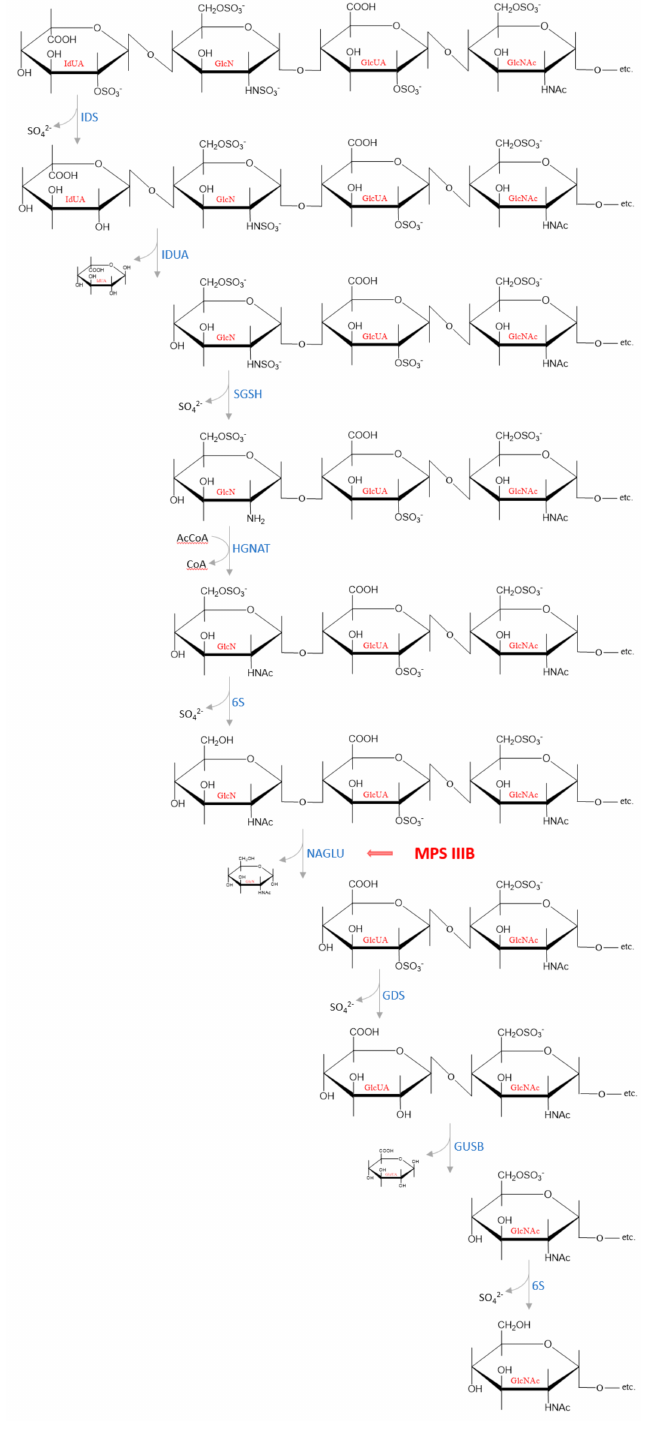
Figure 3. An example of how the subsequential degradation from the non-reducing end of the tetrasaccharide IdUA2S ( α 1 − 4)—GlcNS6S ( α 1 − 4)—GlcA2S ( β 1 − 4)—GlcNAc6S occurs in the lysosome by HS degrading enzymes. Abbreviations: IdUA = iduronic acid; GlcN = glu- cosamine; GlcUA = glucuronic acid; GlcNAc = N − acetylglucosamine; IDS—iduronate − 2 − sulfatase (EC 3.1.6.13); IDUA— α − L − iduronidase (EC 3.2.1.76); SGSH— N − sulfoglucosamine sulfohy- drolase (EC 3.10.1.1); HGNAT heparan − α − glucosaminide N − acetyltransferase (EC 2.3.1.78); 6S— N − acetylglucosamine − 6 − sulfatase (EC 3.1.6.14); NAGLU— α − N − acetylglucosaminidase (EC 3.2.1.50); GDS—glucuronate − 2 − sulfatase (EC 3.1.6.18); GUSB— β − glucuronidase (EC